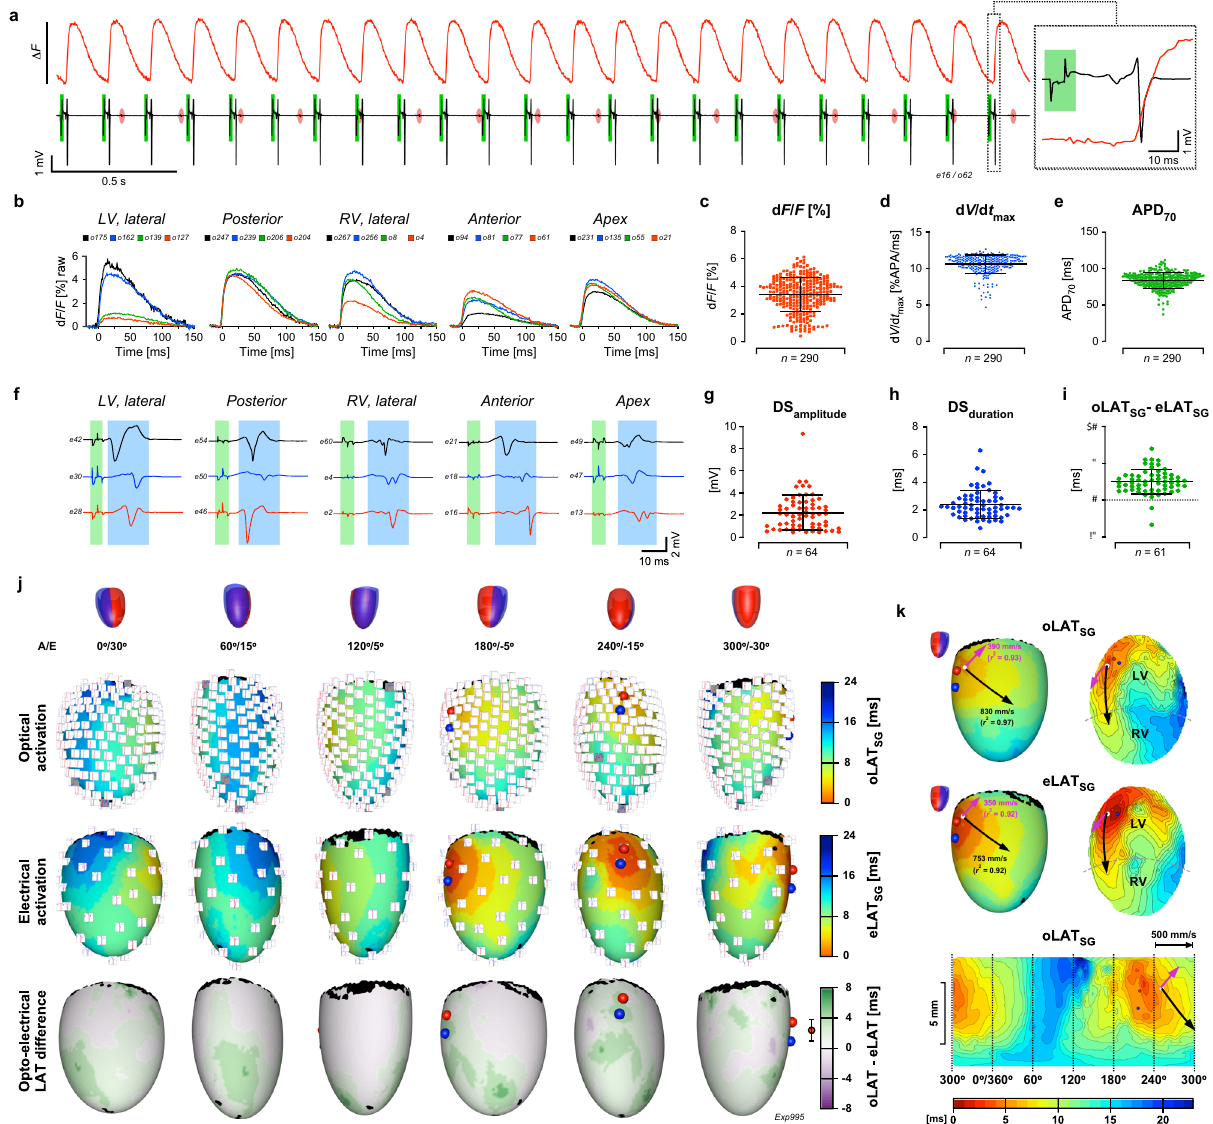
Fig. 3 Panoramic optoelectrical recordings from an electrically stimulated Myh6-Cre Tg /ArcLight-Q239 lox/wt heart. a Optical trace (top) and electrical trace (bottom; red ovals: atrial activity; green rectangle: stimulation artifact) as recorded simultaneously by a single optical fi ber and by an adjacent electrode during epicardial stimulation at 6 Hz. The last activation is shown in expanded form on the right. b Un fi ltered optical action potentials (oAPs) recorded by a selection of individual fi bers that image different regions of the heart (LV: left ventricle; RV right ventricle). c Fractional fl uorescence changes (d F / F ) of oAPs. d Distribution of maximal upstroke velocities (d V /d t max ) of oAPs. e Durations of oAPs measured at 70% repolarization (APD 70 ). f Electrograms of different regions of the heart (green bands: stimulation artifact; blue bands: local electrogram). g Distribution of downstroke (DS) amplitudes and h downstroke durations of all electrograms recorded during a single ventricular activation. i Distribution of local differences between optically and electrically determined local activation times (oLAT SG − eLAT SG ). j Schematic of heart orientation (A: angle; E: elevation; red: left ventricle; blue: right ventricle) with corresponding 3D maps of optically determined activation (top; with miniaturized signals at the recording sites), electrically determined activation (center), and optoelectrical LAT differences (bottom) with mean ± SD values shown on the left of the color bar ( n = 61). The location of the stimulation electrodes is indicated by a red and blue sphere, respectively. k 3D map and central projection of optically (top: oLAT SG ) and electrically (center: eLAT SG ) determined ventricular activation sequences. Bottom: Mercator projection of the optically determined activation sequence. White disc: site of initial activation; black arrow: direction of fastest activation; red arrow: propagation perpendicular to the black arrow (arrow lengths are scaled to the conduction velocities). “ n ” refers to the number of signals produced by the recording sites during a single activation of the heart. Error bars refer to ±SD. Source data are provided as a Source Data fi illustrated by the 3D activation maps shown in Fig. 3j, optically and positive components of the biphasic current pulse. These and electrically determined activation patterns were qualitatively procedures permitted eLAT determinations also in the vicinity of similar (for animation cf. Supplementary Movie 3). However, the the stimulation electrodes (e.g., trace e 42 in Fig. 3f was recorded at slow kinetics of ArcLight-Q239 caused oLAT 50% to be con- a distance of 1.3 mm from to stimulation site). Electrograms were characterized by a mean amplitude of 2.25 ± 1.60 mV and a sistently delayed in respect to eLAT SG by 2.42 ± 1.67 ms (Fig. 3i downstroke duration of 2.34 ± 1.03 ms (Fig. 3g, h; n = 64). As and bottom panel of Fig. 3j; n = 61). Stimulated ventricular